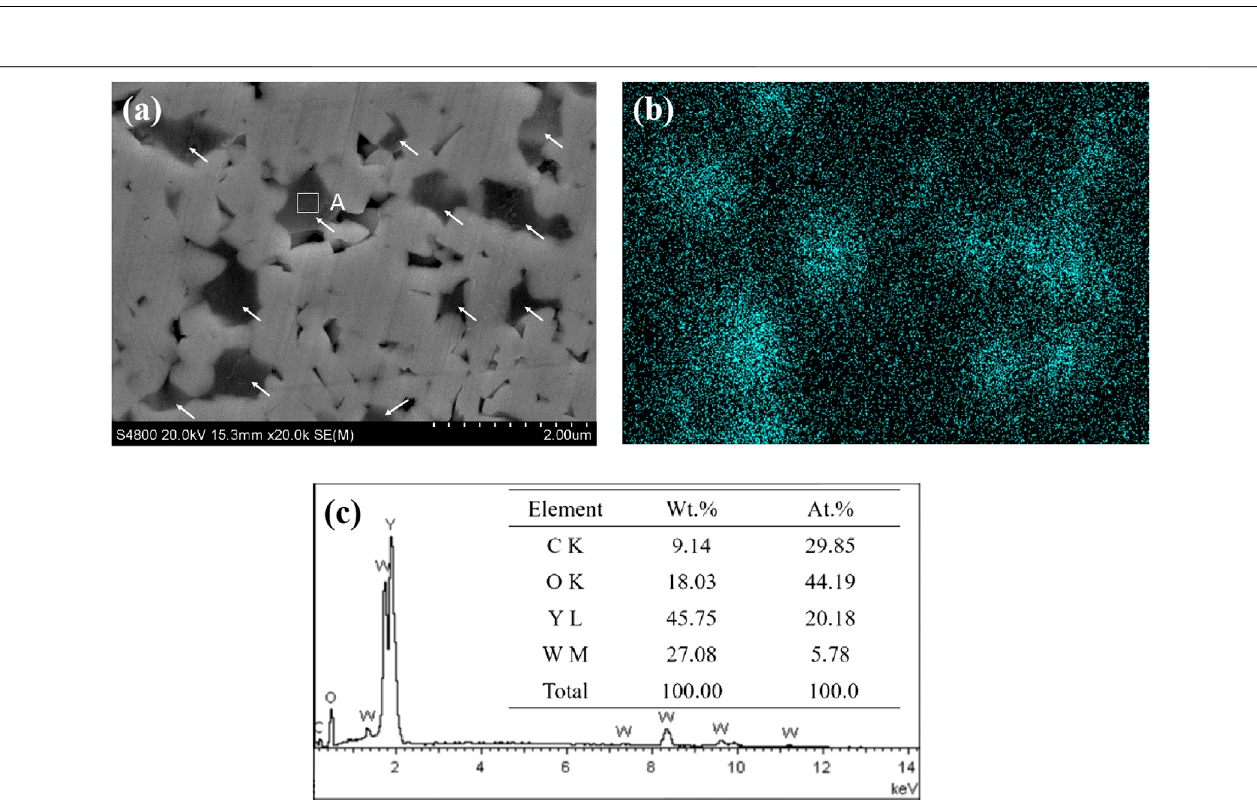
FIGURE 8 | SEM surface morphology (A) and elemental analysis of WC-4wt.% Y 2 O 3 (B,C) . (B) The distribution of yttrium in Panel (A) ; (C) EDS analysis result of micro zone A in Figure. a.